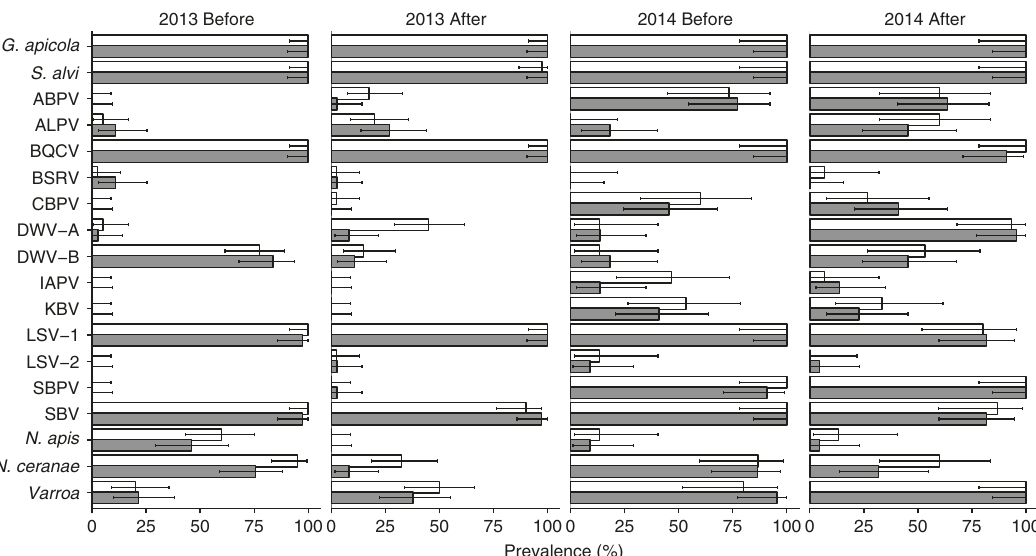
Fig. 4 Microorganism/parasite prevalence. Percentage (±95% con fi dence limits) of honeybee colonies infected with the gut bacteria Gilliamella apicola and Snodgrassella alvi , the viruses acute bee paralysis virus (ABPV), aphid lethal paralysis virus (ALPV), black queen cell virus (BQCV), big Sioux River virus (BSRV), chronic bee paralysis virus (CBPV), deformed wing virus type-A (DWV-A), deformed wing virus type-B (DWV-B), Israeli acute paralysis virus (IAPV), Kashmir bee virus (KBV), Lake Sinai virus type-1 (LSV-1), Lake Sinai virus type-2 (LSV-2), slow bee paralysis virus (SBPV), Sacbrood virus (SBV), the microsporidians Nosema apis, Nosema ceranae or infested with the Varroa mite ( Varroa destructor ) in relation to treatment (control = white bars; clothianidin-treated = grey bars) in oilseed rape fi elds ( n = 8 fi elds per treatment in 2013; n = 4 control and n = 6 treated fi elds in 2014) before and after the oilseed rape bloom in two years (2013 and